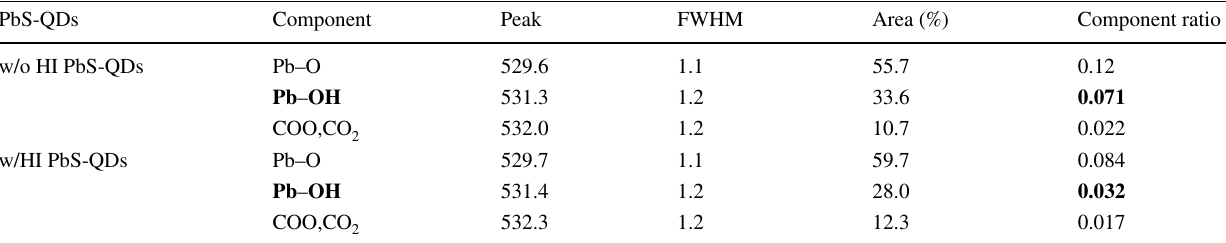
The bold words were marked to highlight the changes of trap groups, OH group in QDs, in the XPS